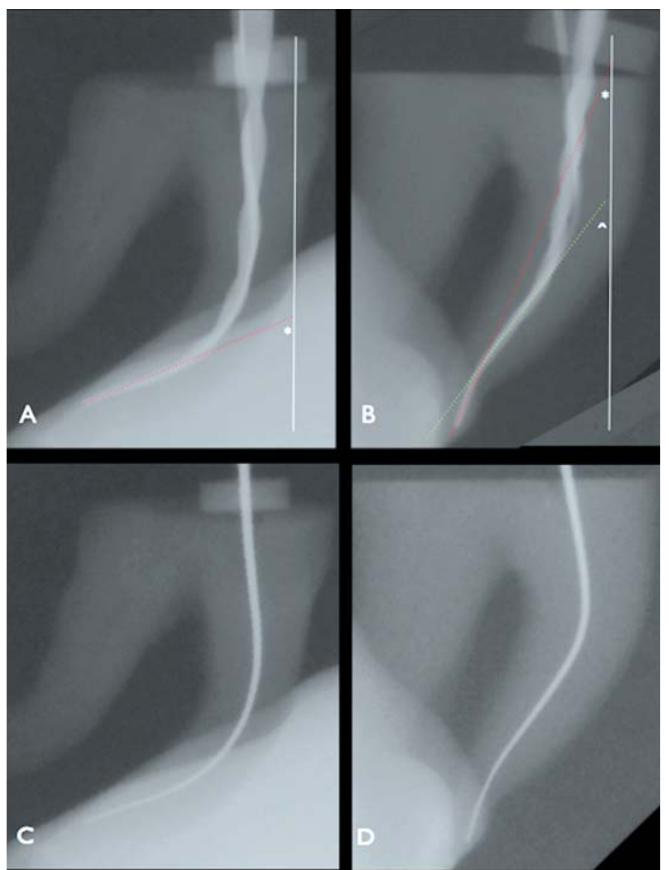
Figure 2- Radiographic images after superimposition of 62-degree (A) and “S”-shaped (B) root canal curvatures of molar replicas. The angle (*) was formed by the intersection of the root canal axis at the apical third (red line) and the long axis that is perpendicular to the coronal level (white line). The evaluation of the S-shaped curvature included the measurement of the angles of the primary (*) and of the secondary curvature (ˆ). Preoperative radiographs are shown in